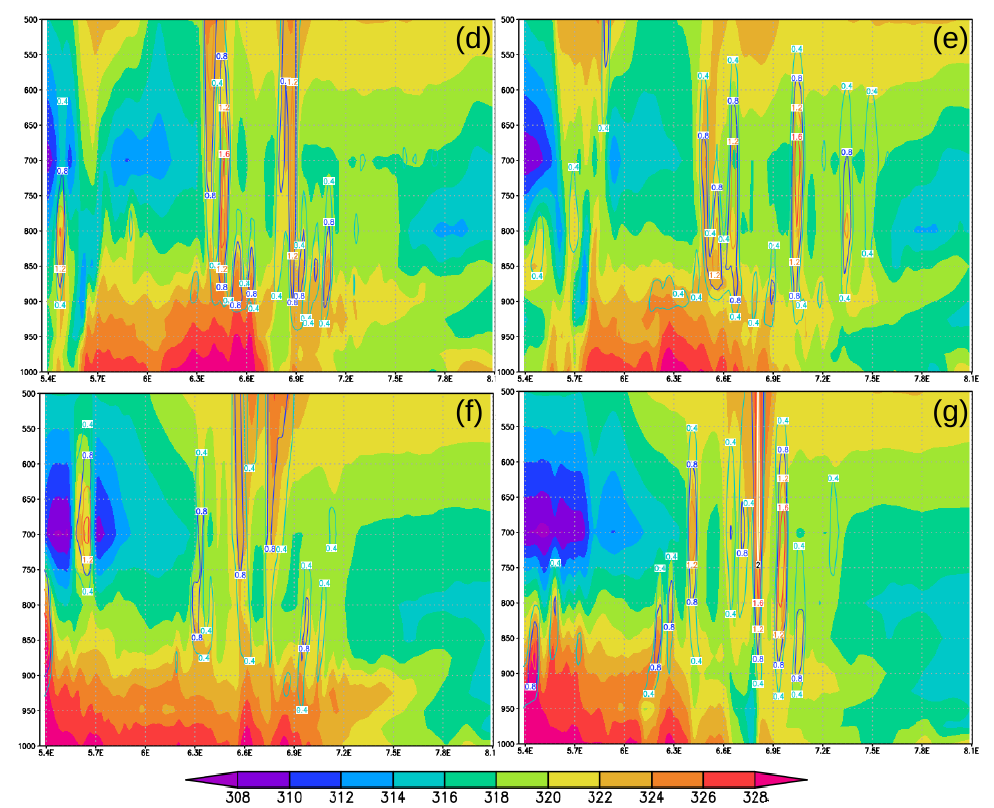
Figure 13. Equivalent potential temperature (K, shaded contours) and cloud water mixing ratio (g kg − 1 , line contours) cross sections, taken at 43.65 ◦ N, and shown in panel ( a ), at 19 UTC, 3 October 2015 for ( b ) W_GFS, ( c ) W_GFS_SST, ( d ) W_ECM, ( e ) W_ECM_SST, ( f ) W_GFSANL and ( g ) W_GFSANL_SST simulations.